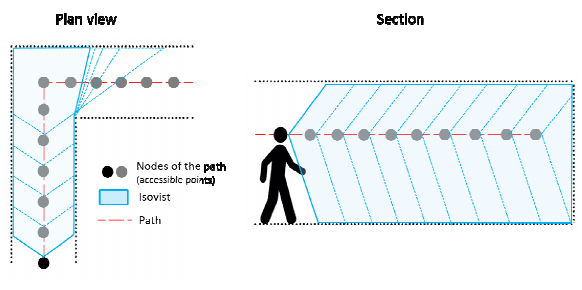
Figure 9. 3D isovist field